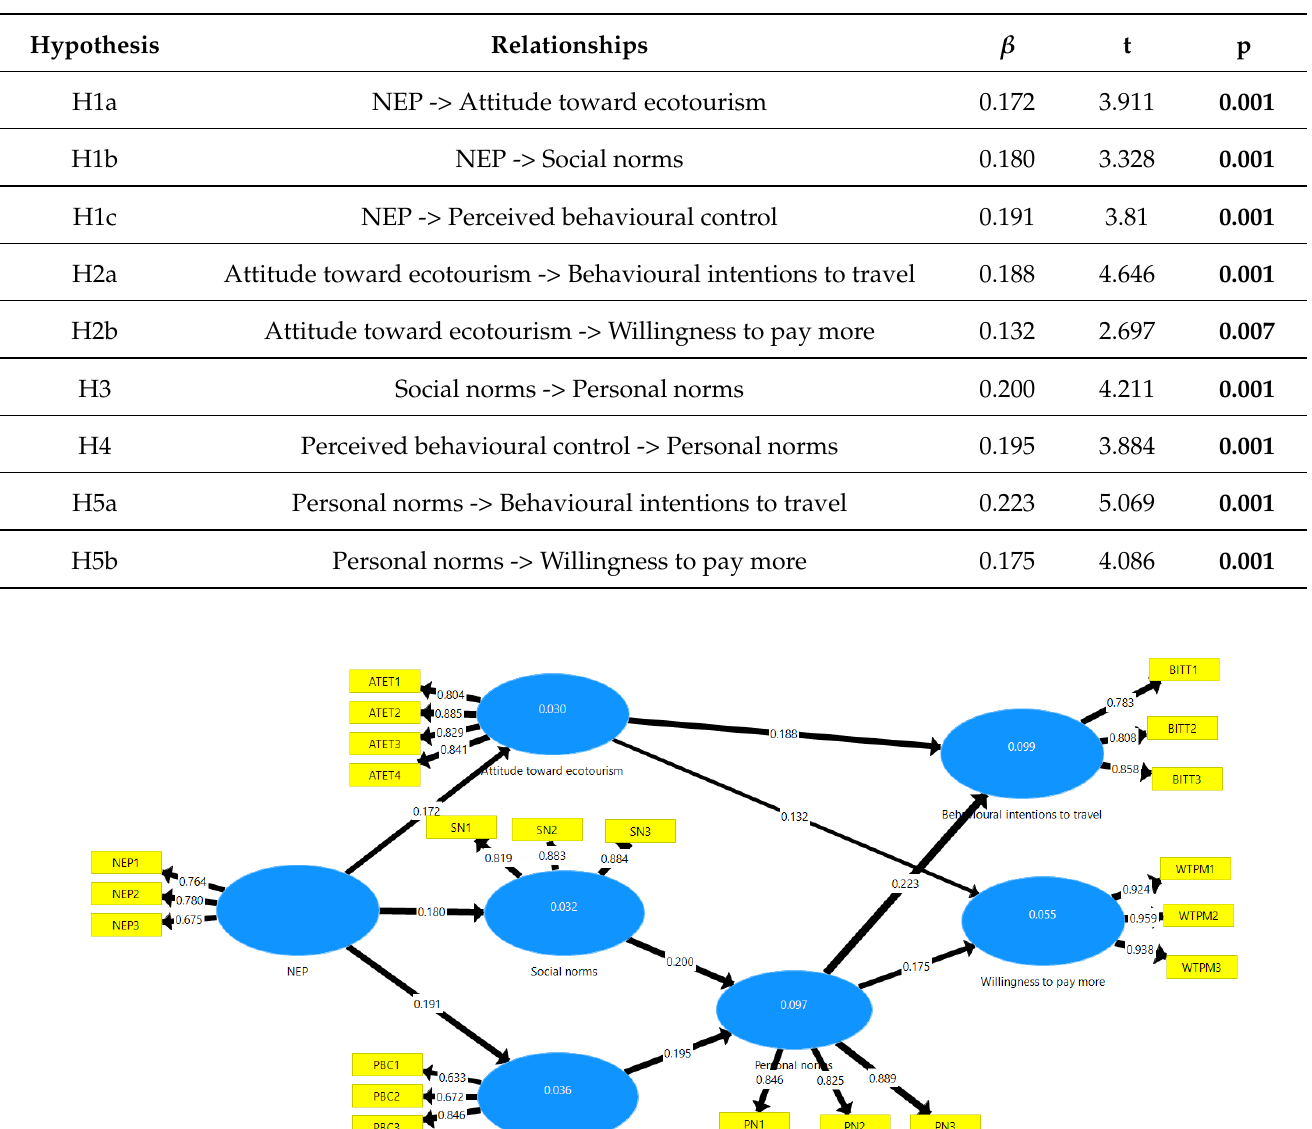
Table 4. Calculated path coefficients.